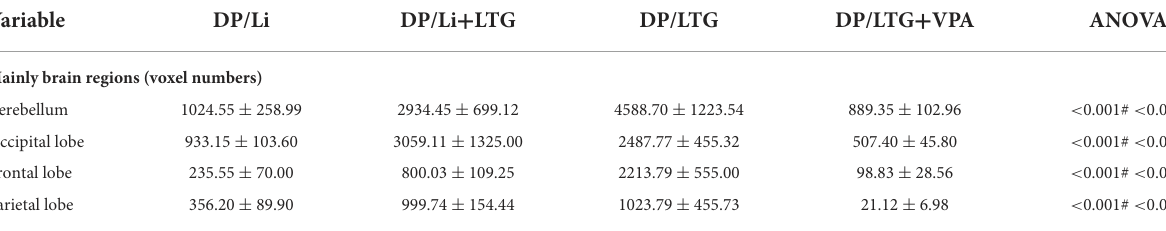
TABLE 2 rs-CBF alterations before and after